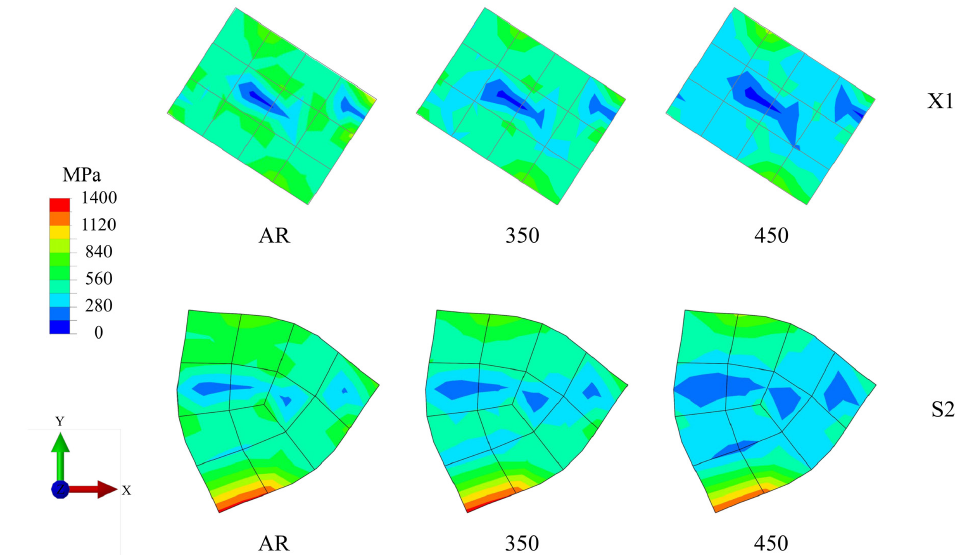
Figure 5. The von Mises stress distribution in the cross-section at 3 mm from the tip under bending at 45°. Note that the neutral lines are set in the x direction, which means that the flexural displacement was applied in the y